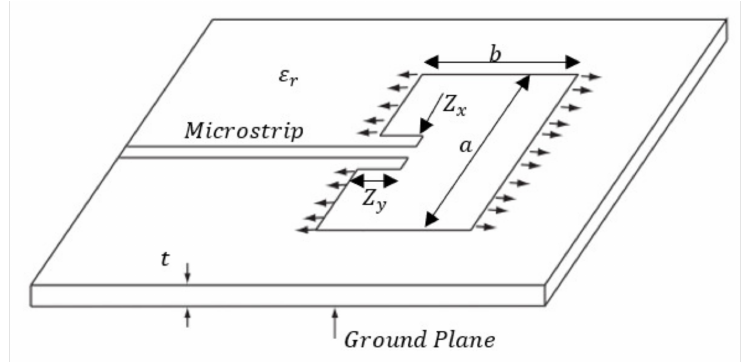
Figure 3. Schematic of a patch antenna.